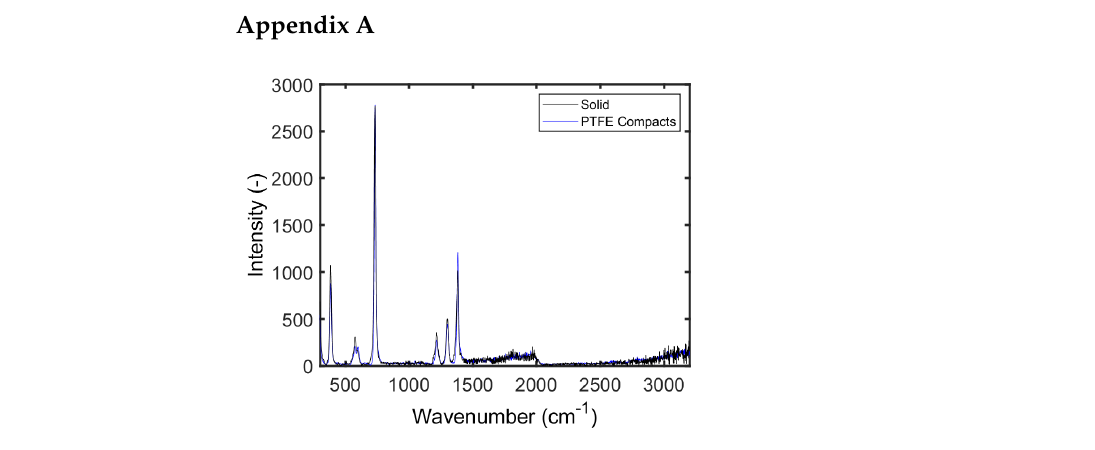
Figure A1. Raman spectra (Bruker Bravo, Billerica, Massachusetts, United States) of PTFE pellets and solid PTFE showing no changes in crystalline or amorphous character.